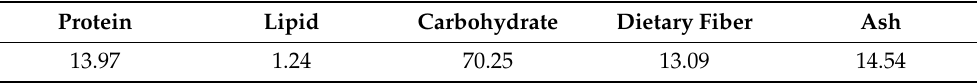
Table 2. Chemical composition of Sargassum zhangii (%, w / w on the dry basis). Chemical composition includes protein, lipid, ash, carbohydrate, and dietary